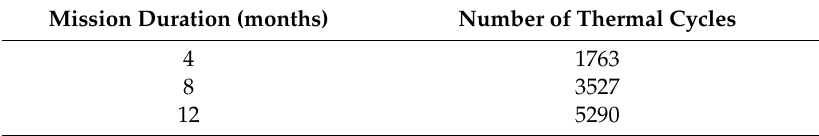
Table 7. The number of thermal cycles for di ff erent mission durations of